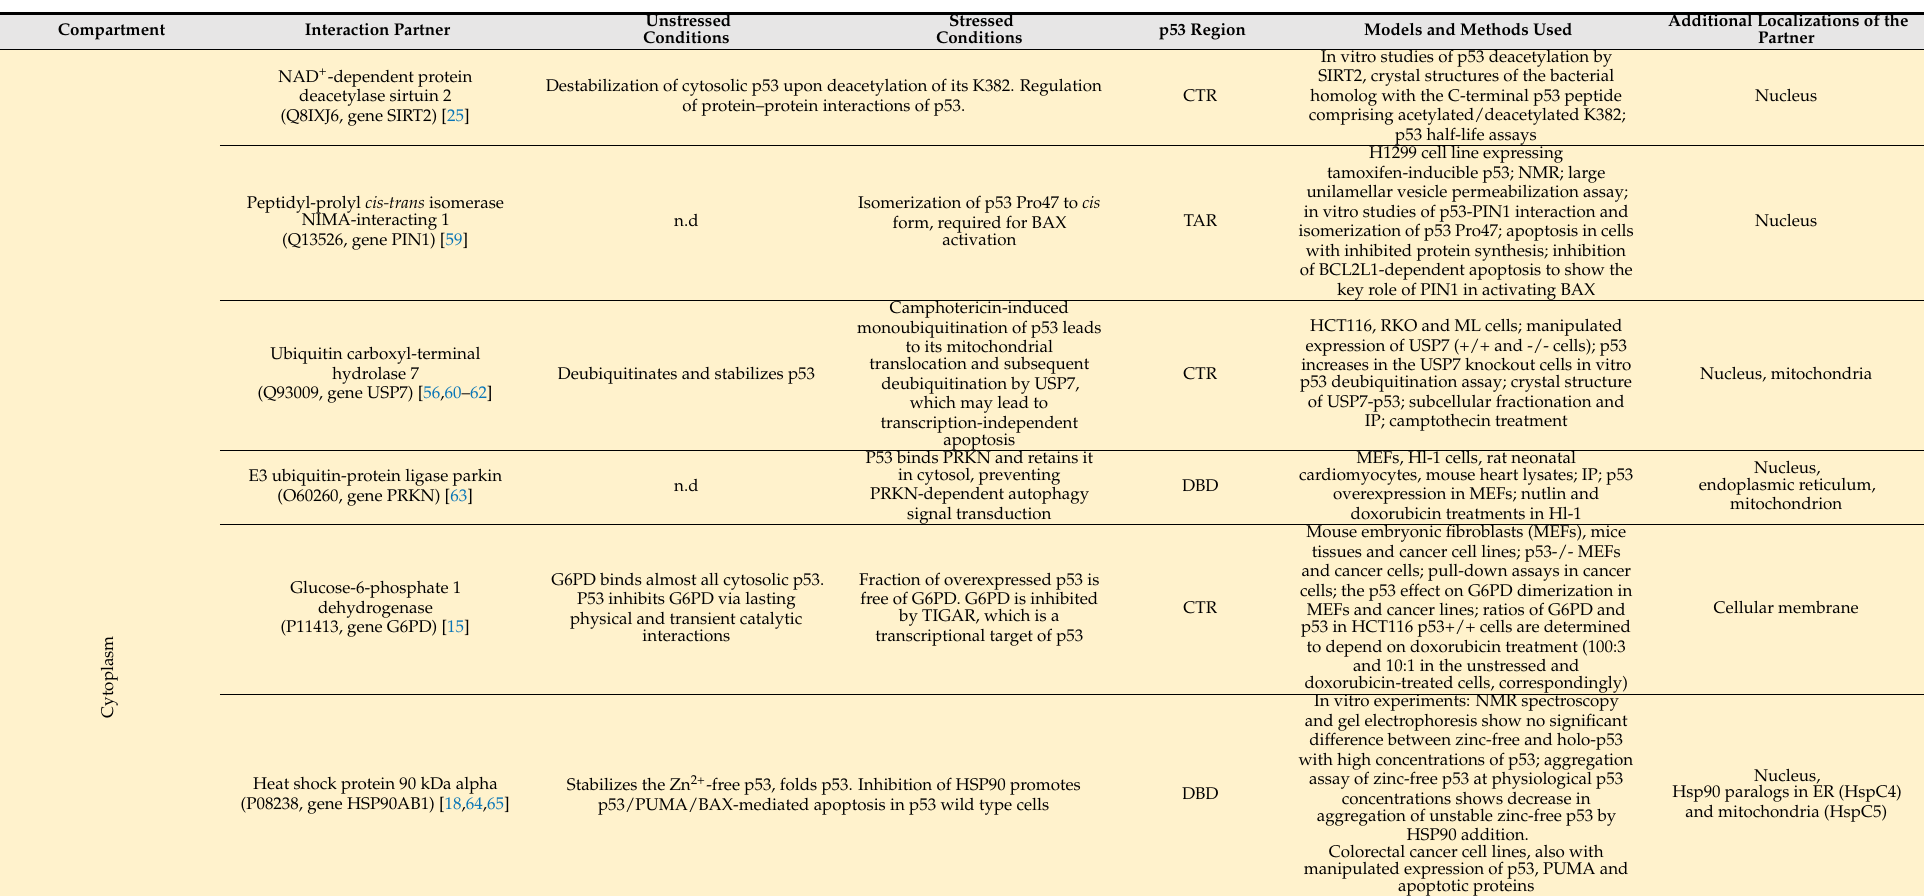
Table 1. Non-nuclear protein complexes of p53 and their role in p53 functions. The human protein identifiers, gene names and intracellular localizations are indicated, according to the Uniprot